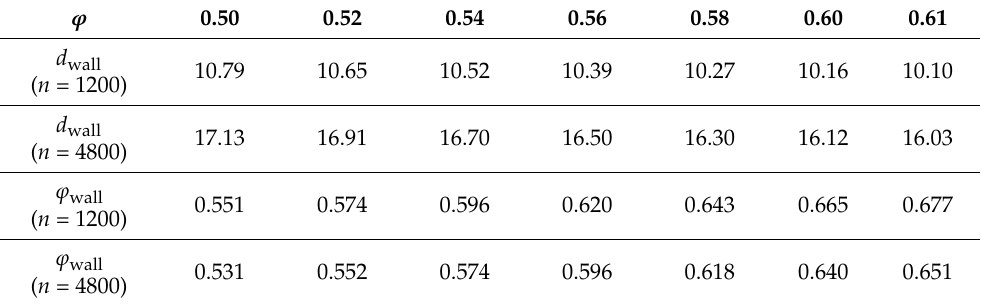
Table 1. Packing density, ϕ , inter-wall distance, d wall , and reduced packing density, ϕ wall , for the systems of n = 1200 ( N = 12 and 24) and 4800 ( N = 50 and 100) interacting spheres.